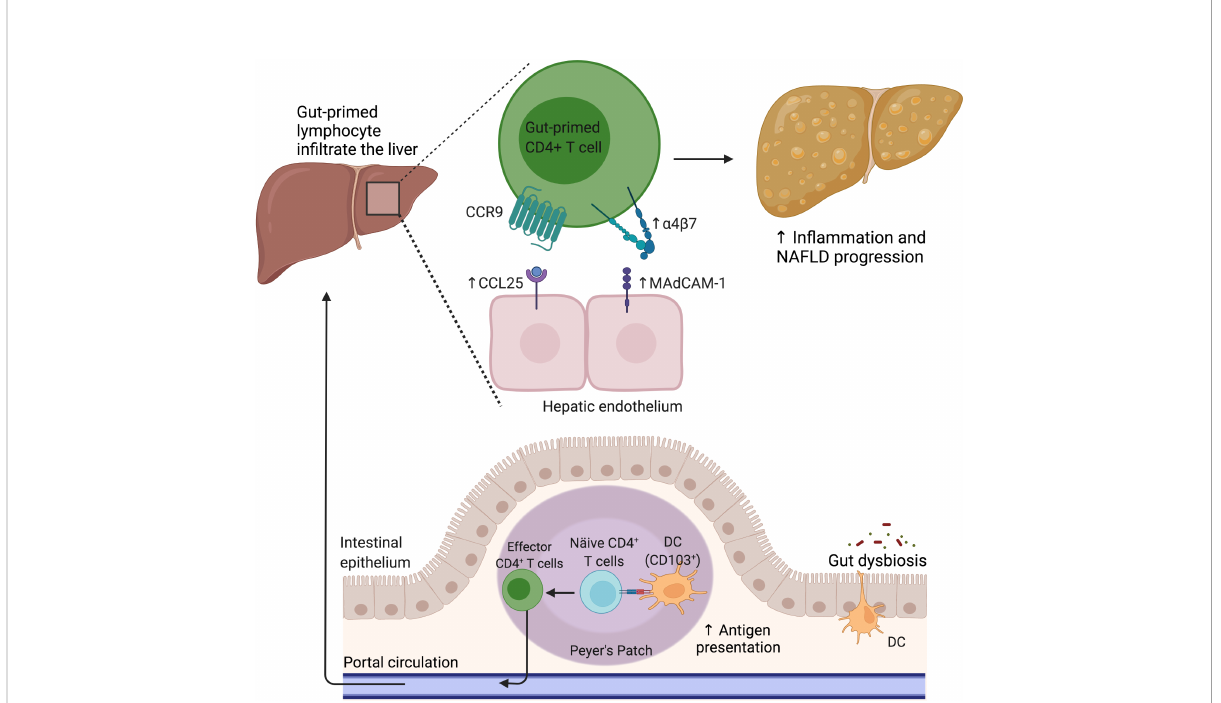
FIGURE 3 The gut lymphocyte is homing in the NAFLD liver. Under physiological conditions, dendritic cells imprint gut-homing speci fi city on T cells in the Peyer ’ s patches or mesenteric lymph nodes by inducing the upregulation of a 4 b 7 integrin and CCR9. Nevertheless, during NAFLD, the hepatic endothelium aberrantly expresses CCL25 and MAdCAM-1, allowing the pathologic recruitment of gut-primed lymphocytes into the liver. CCL25, C-C motif chemokine ligand 25; CCR9, C-C motif chemokine receptor 9; DC, Dendritic cell; MAdCAM-1, Mucosal addressin cell adhesion molecule 1; NAFLD, Nonalcoholic fatty liver